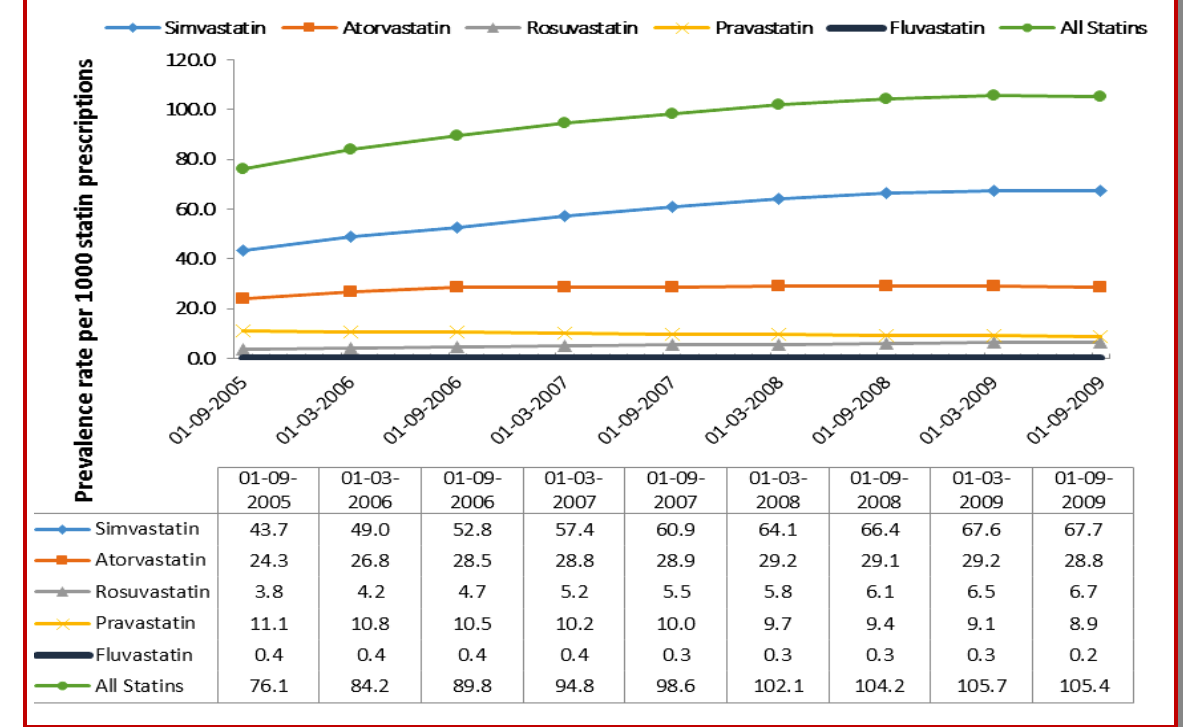
Figure 1: Prevalence rate per thousand statin prescriptions in Scotland from 2005 to 2010